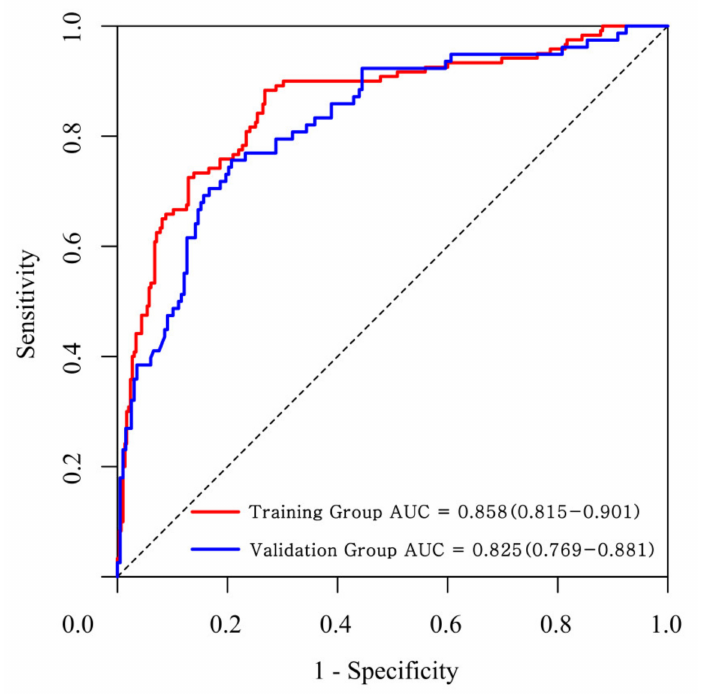
Figure 2. Receiver operating characteristic (ROC) curve of the nomogram for the training group and the validation group.